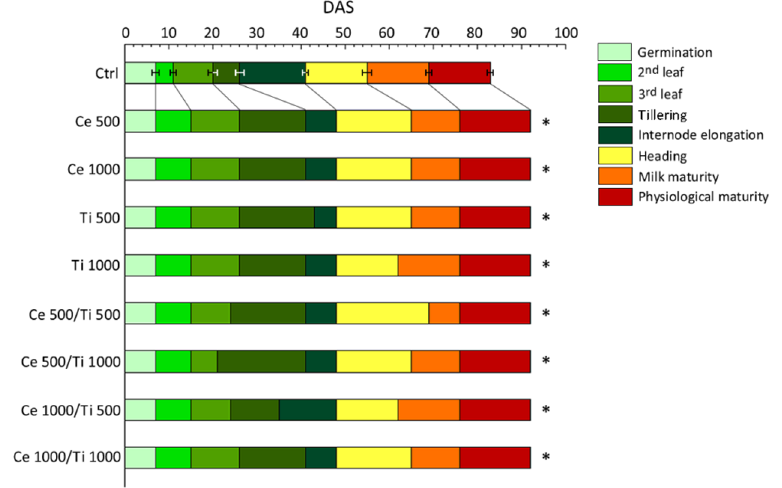
Figure 1. Cumulative contribution of vegetative and reproductive phenophases to the phenology of plants of barley grown in control soil and n CeO 2 and n TiO 2 -amended soil. DAS = days after sowing. Error bars represent ± standard error. * denote significant differences with respect to control ( p ≤ 0.05).